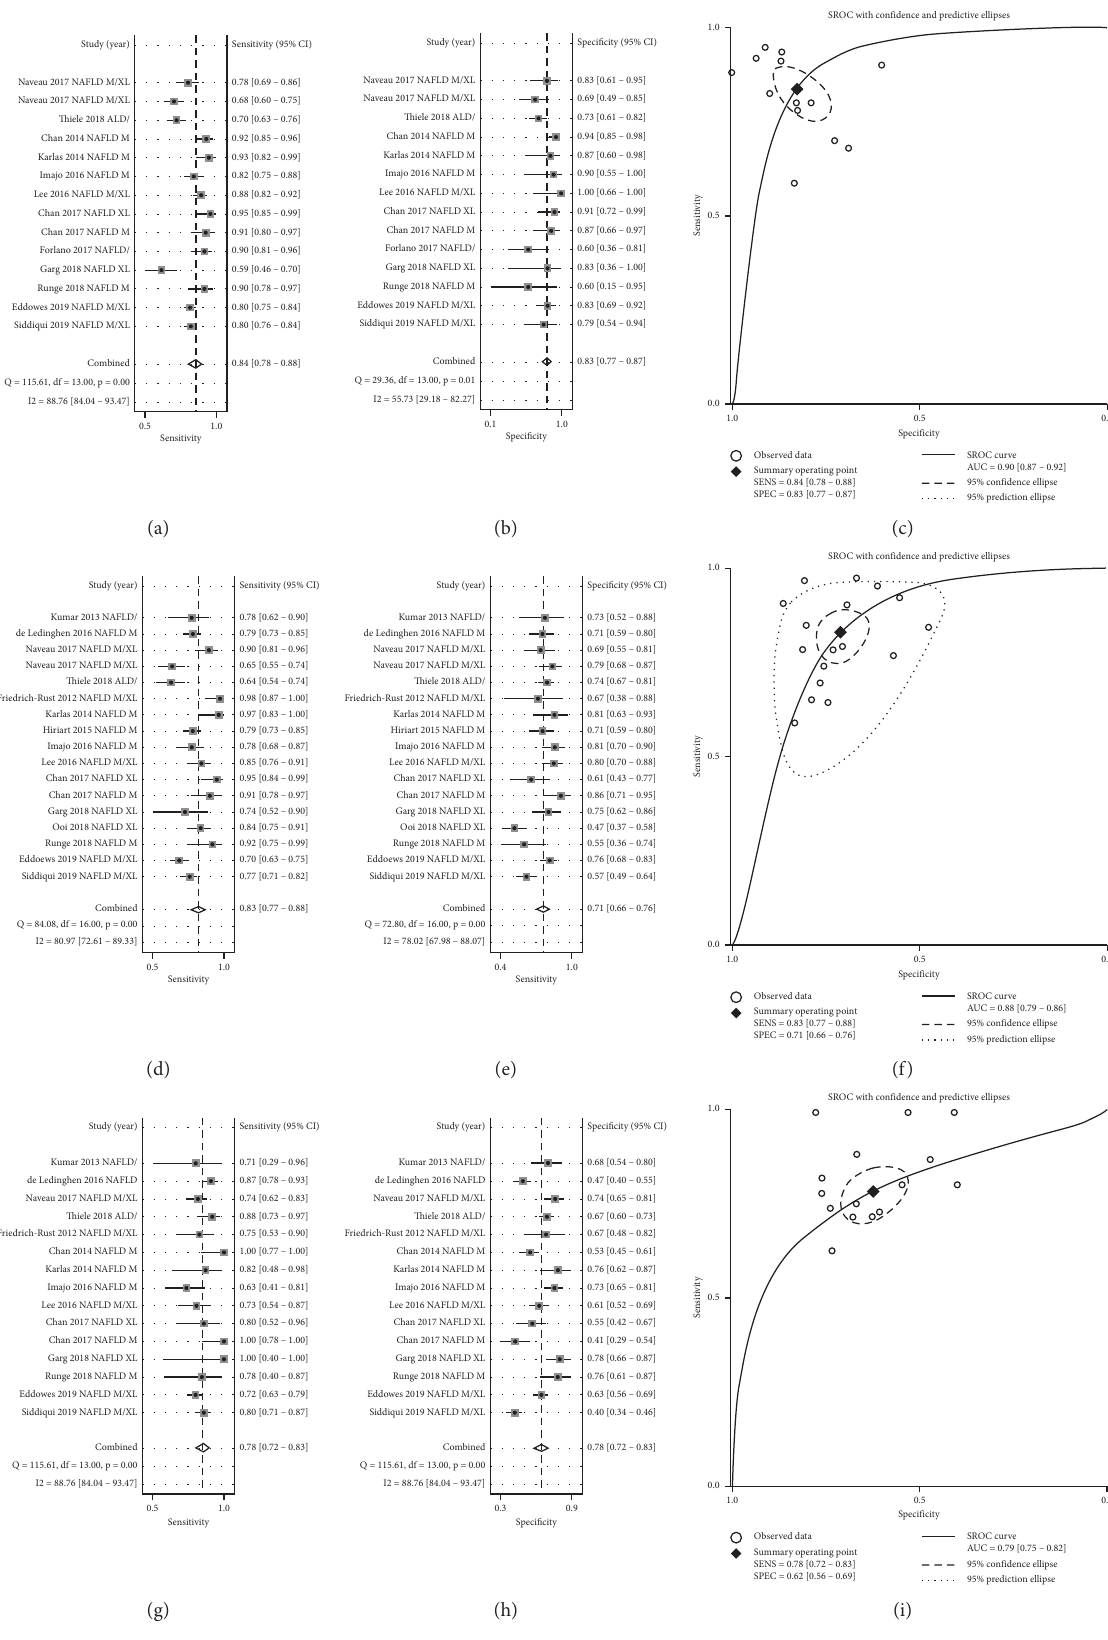
Figure 2: Diagnosticperformanceofcontrolledattenuationparameter(CAP)forsteatosisinalcoholicliverdisease/nonalcoholicfattyliverdisease. (a) Sensitivity, (b) specificity, and (c) summary receiver-operating characteristics (SROC) curve of CAP for identifying patients with steatosis grade ≥ S 1.(d)Sensitivity,(e)specificity,and (f)SROCcurveof CAPfor identifyingpatients withsteatosis grade ≥ S 2.(g) Sensitivity,(h) specificity,and (i) SROC curve of CAP for identifying patients with steatosis grade � S 3. CAP: controlled attenuation